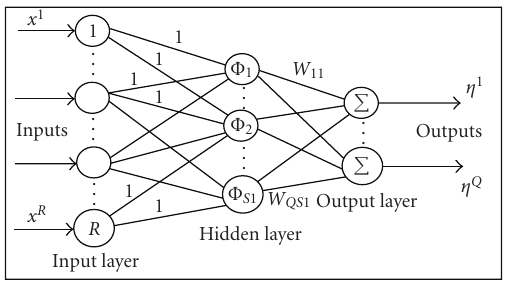
Figure 1: Radial Basis Function Neural Network.